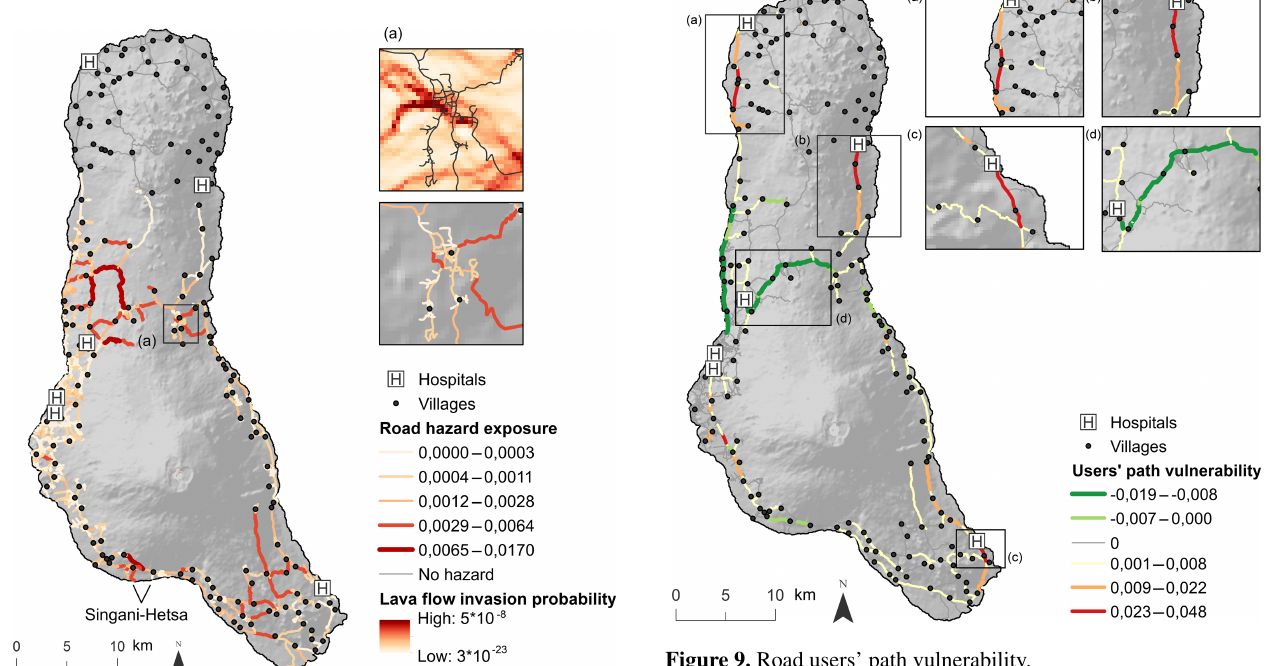
Figure 9. Road users’ path